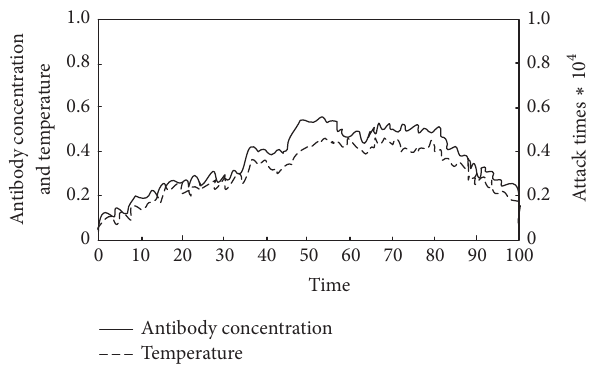
Figure 8: Host 𝑠 1 of antibody concentration and temperature eval- uation factor.